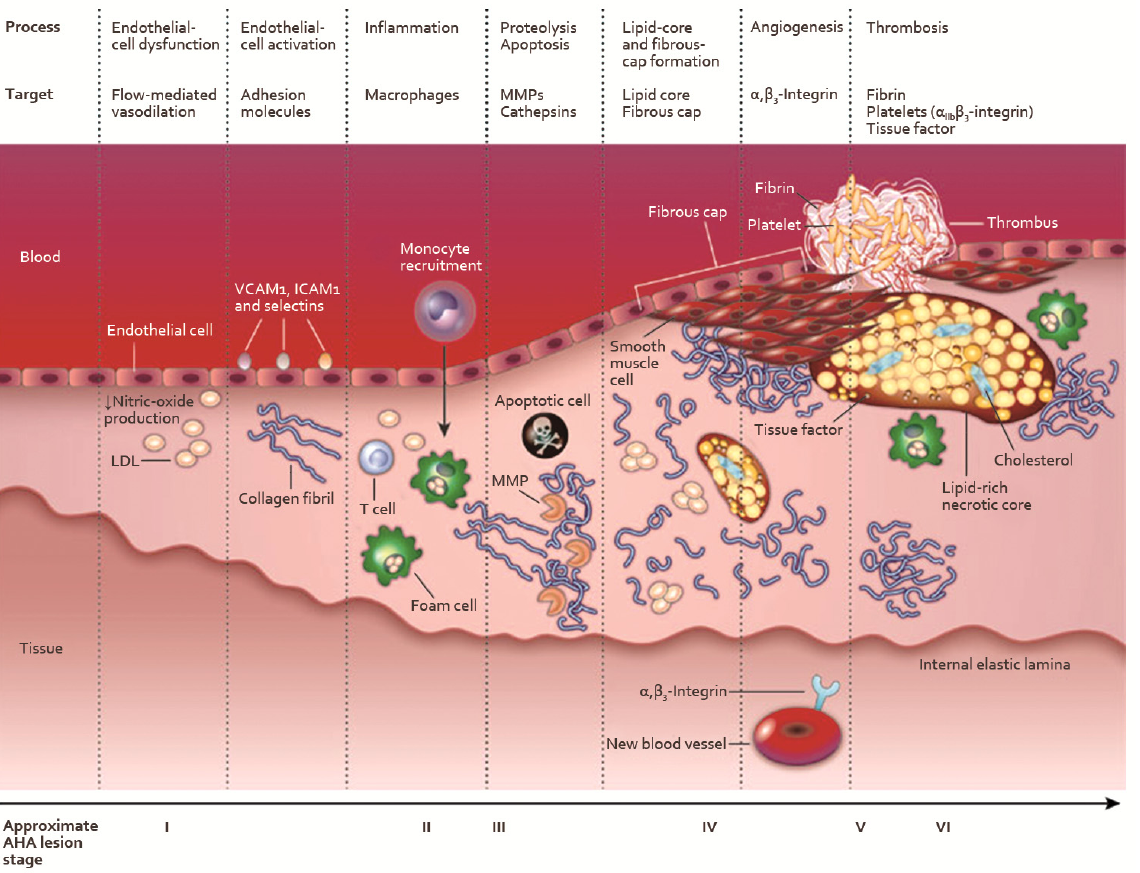
Figure 8. Evolution of atherosclerosis disease and the main targets at each step, according to the American Heart Assocciation (AHA). Reproduced with permission from